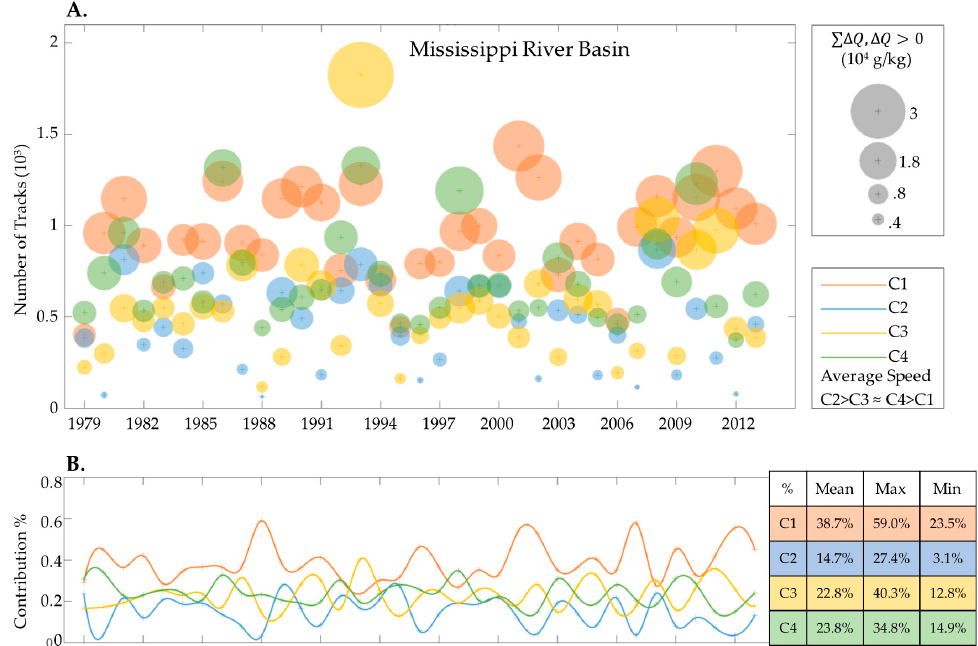
Figure 6. Contributing number of TMEs tracks and the associated moisture release from each cluster for the Mississippi river basin. ( A ) the colors of the circles are consistent with the clusters in Figure 4. The center of the colored circle shows the total number of tracks (vertical axis) from the identified source to the basin for each year (bottom axis). The size of the circle represents the total amount of moisture release of those tracks. The size is proportional to ( ∑ Δ Q ) 1.5 . The scale reference of the circle is the panel on the right. The order of the clusters’ traveling speeds is given for fast reference to Figure 4B. ( B ) the colored lines show the smoothed time series of the annual contribution of each cluster in terms of moisture release. The contribution is calculated as the percentage of the total. The summary statistics of their contributions (mean, maximum and minimum values) are tabulated in the colored table. The colors of the clusters are consistent over the entire paper.